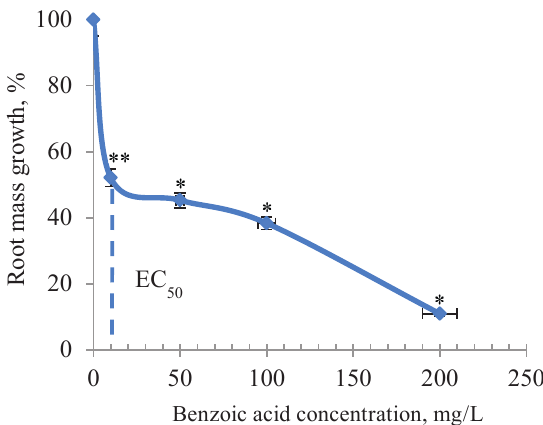
Figure 2 Root mass growth inhibition after treatment with